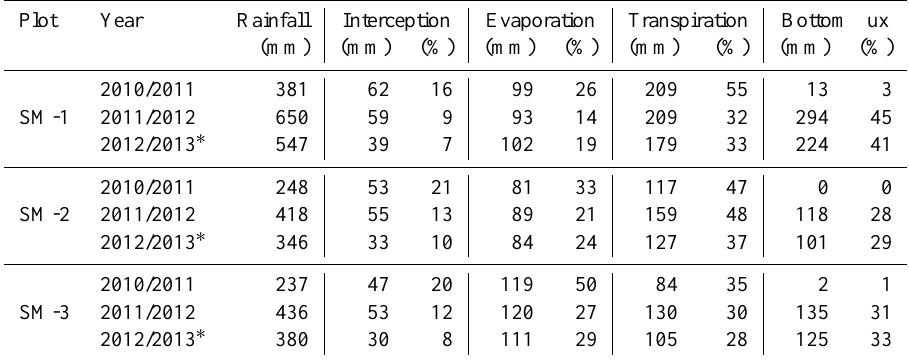
Figure 6. Observed volumetric soil moisture at different depths of the three experimental plots during the complete monitoring period (a) and details on the winter season 2011/2012 for plot SM-1 (b) . Table 4. Cumulative sums of the simulated water balance components in millimetres and percentages for the three consecutive hydrological years 2010–2013 at the individual soil moisture